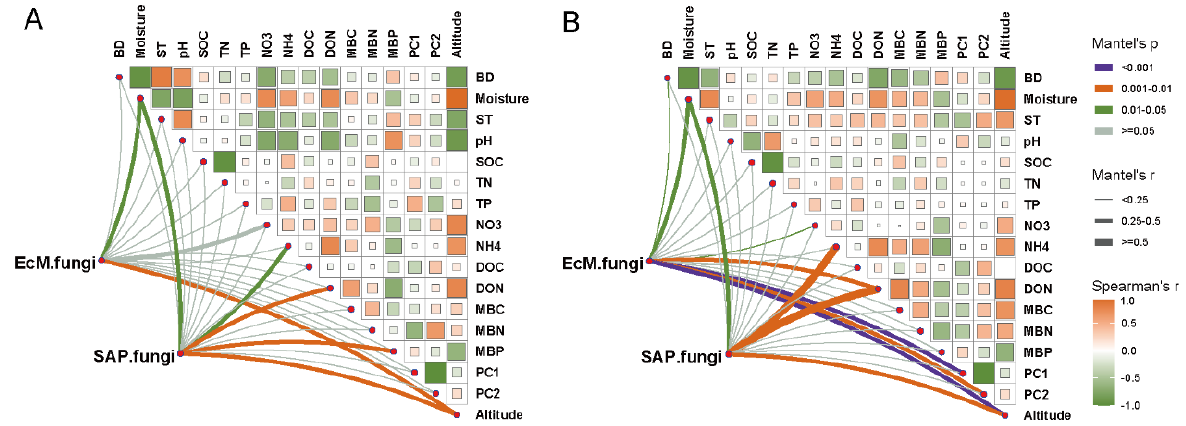
Figure 6. Abiotic and biotic drivers of the EcM and SAP fungal community compositions. (A) 0–10 cm soil layer; (B) 10–20 cm soil layer. EcM and SAP fungal community compositions (Bray–Curtis distance) were correlated with each environmental or biotic factor by partial Mantel tests. Pairwise comparisons of environmental and biotic factors are shown in the upper-right area, which is repre- sented with a color gradient using Spearman’s correlation coefficients. The edge width represents the partial Mantel’s r statistic for the corresponding correlation, and the edge color indicates that significance is tested following 999 permutations. BD, bulk density; ST, soil temperature; SOC, soil organic carbon; TN, total nitrogen; TP, total phosphorus; NO3, nitrate nitrogen; NH4, ammonium nitrogen; DOC, dissolved organic carbon; DON, dissolved organic nitrogen; MBC, microbial bio- mass carbon; MBN. microbial biomass nitrogen; MBP, microbial biomass phosphorus; PC1 and PC2, the first and second axis scores of plant community composition.